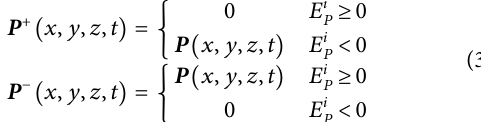
Frontiers in Earth Science |